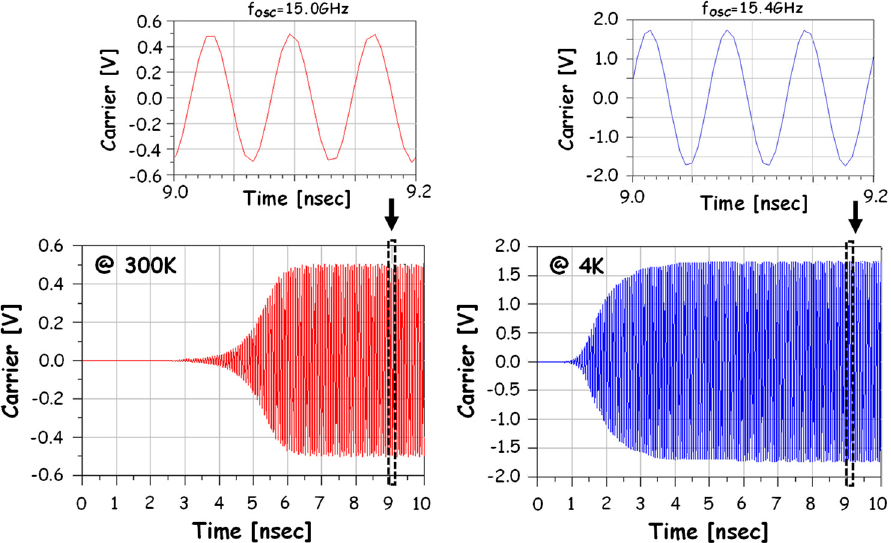
Figure 4. Carrier waveforms at 300 K ( left ) and at 4 K ( right ).